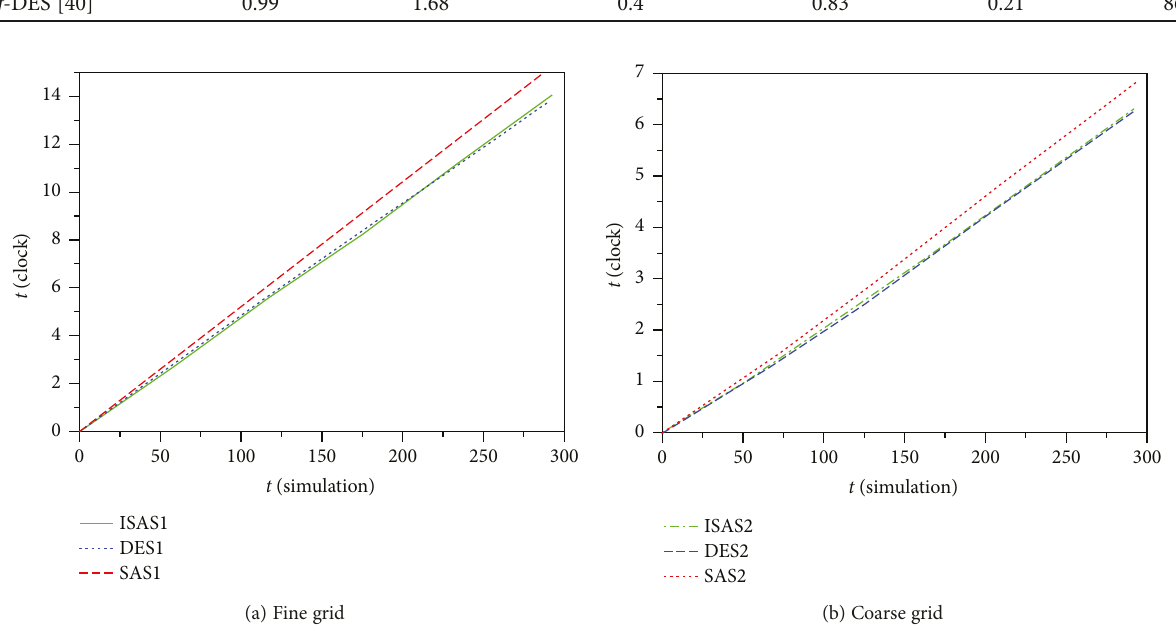
Figure 4: Computational e ffi ciency of ISAS, DES, and